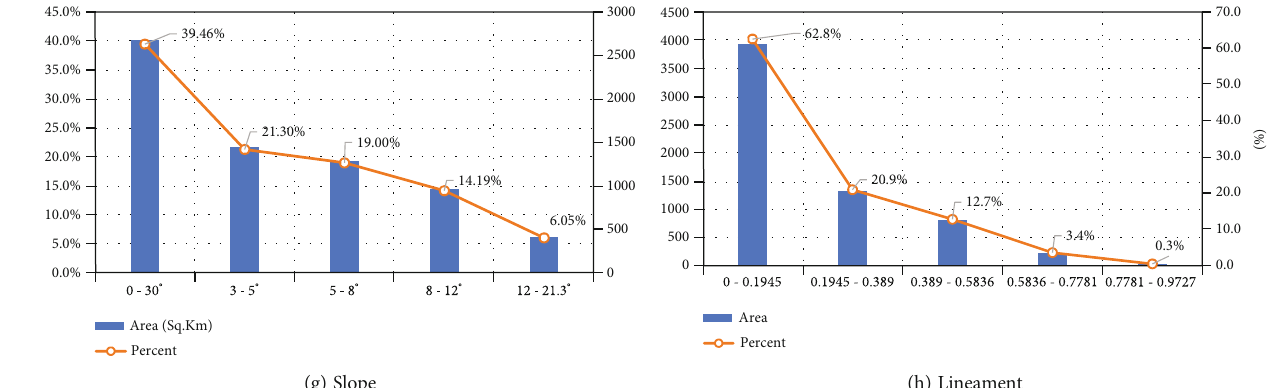
Figure 2: Area percentage (%) covered by the attributes of the study area.